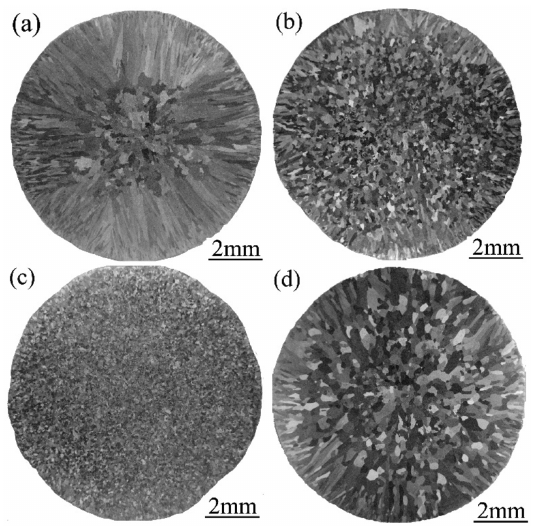
Figure 2: Macrostructures of the tested cylindrical ingots (a) 0% La, (b) 0.1% La, (c) 0.025 La, (d) 0.4% La.